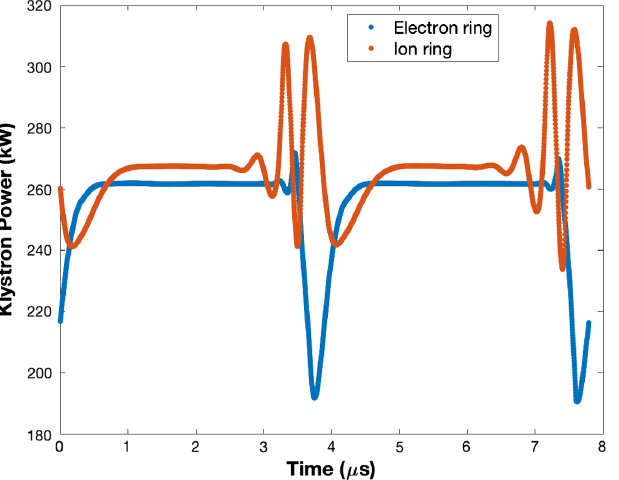
FIG. 10. IP time offset with feedforward.